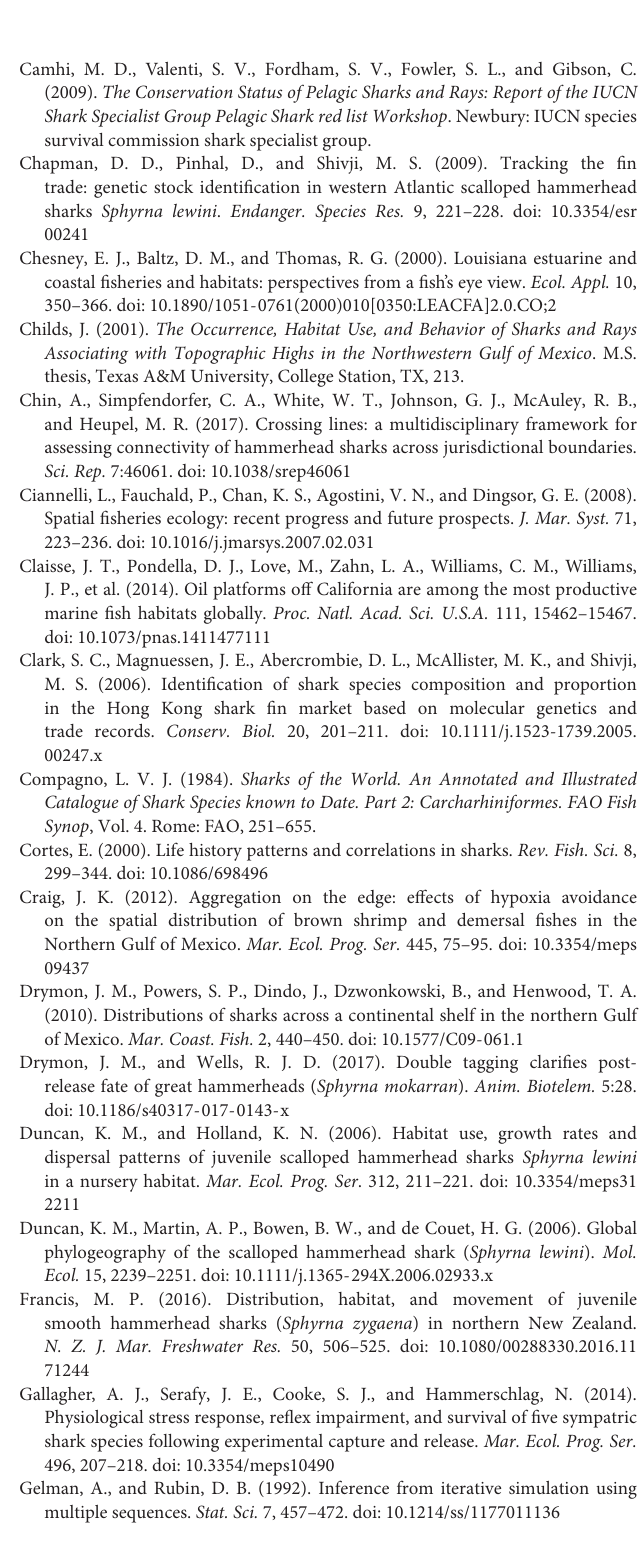
and % deviance explained (% DE). The relative importance of each predictor variable to the final model is given as the difference in model AIC ( (cid:49) AIC) and % DE ( (cid:49) DE) if this variable is removed from the final